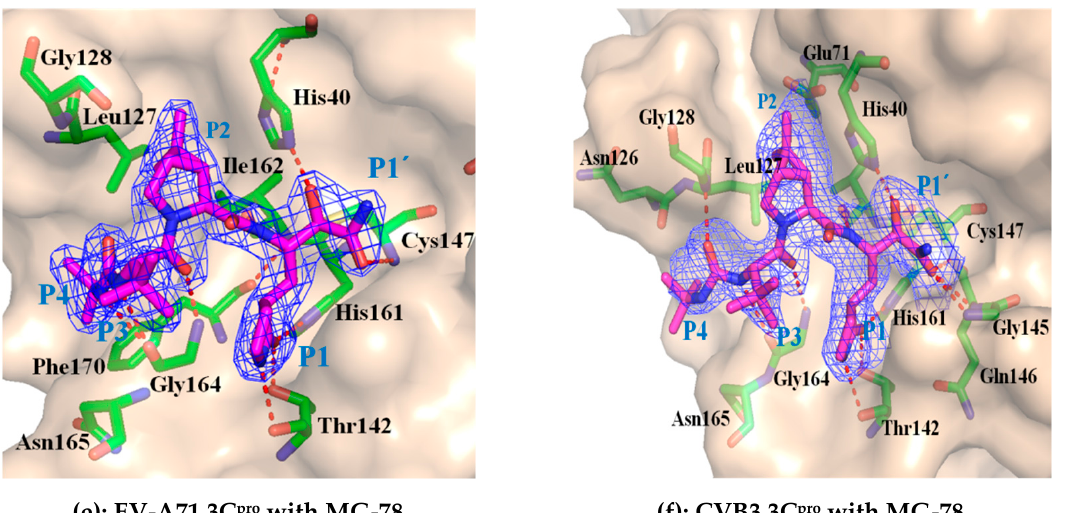
Figure 2. Crystal structures of M pro in complex with boceprevir ( a ), telaprevir ( b ), MG-78 ( c ), and MG-131 ( d ). Crystal structure of EV-A71 3C pro ( e ) and CVB3 3C pro ( f ) in complex with MG-78. The 2Fo-Fc OMIT maps are contoured at 1.5 σ , except for panels a and f, which are contoured at 1.0 σ .